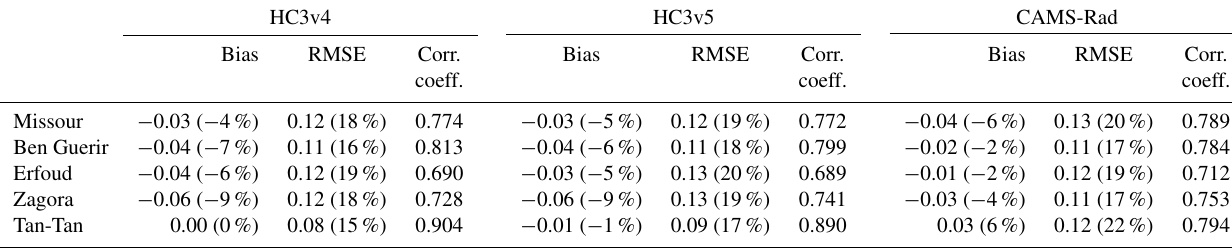
Table 4. Clearness index. Bias, RMSE and correlation coefficient for HC3v5 and